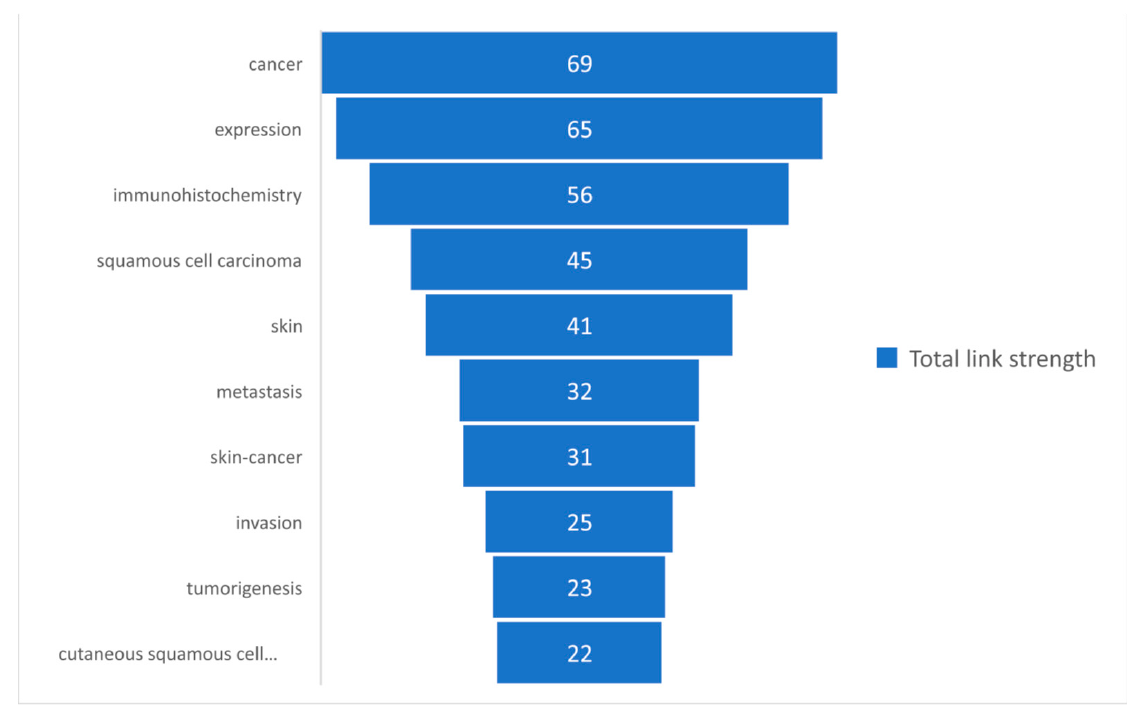
Figure 6. The most commonly used keywords based on the total link strength.